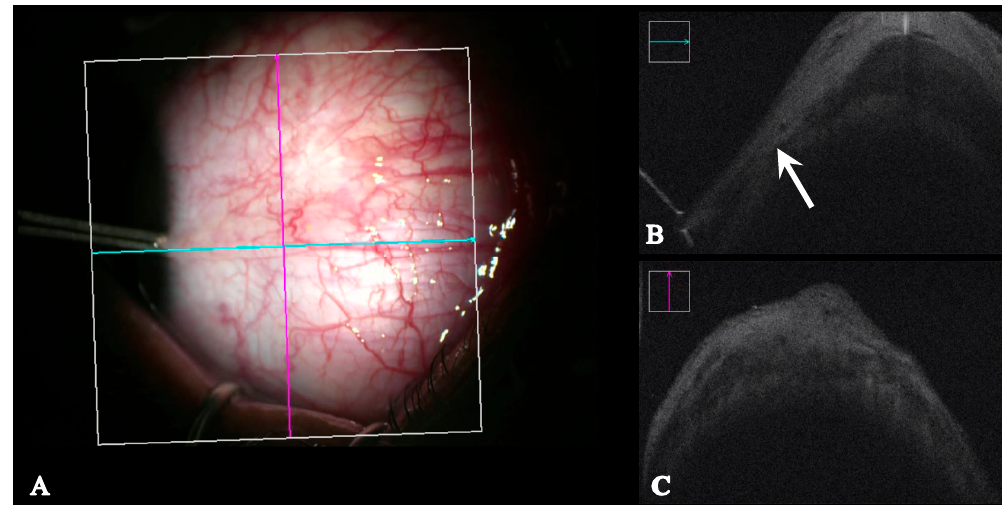
Figure 2. Anterior segment optical coherence tomography (integrated intraoperative microscope, Zeiss Rescan 700 (Carl Zeiss, Germany)) of a previously resected medial rectus muscle. A : intraoperative view. B : arrow marks muscle insertion. C : cross section of muscle shown. view. ( B ): arrow marks muscle insertion. ( C ): cross section of muscle